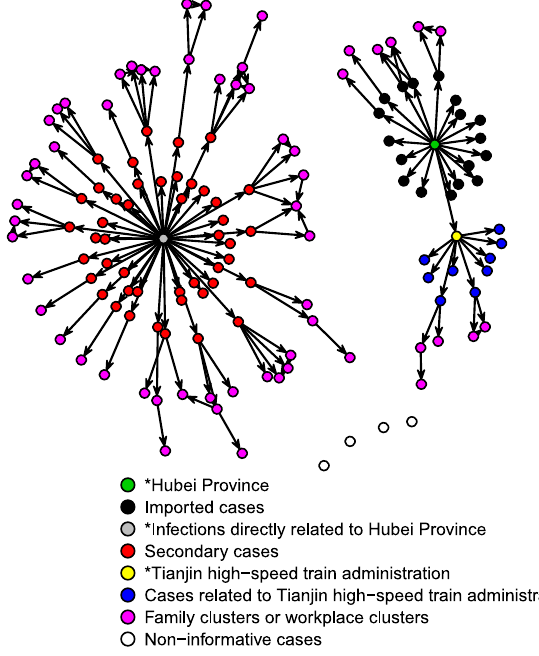
Figure 1. Transmission network graph for confirmed COVID-19 cases in Tianjin.